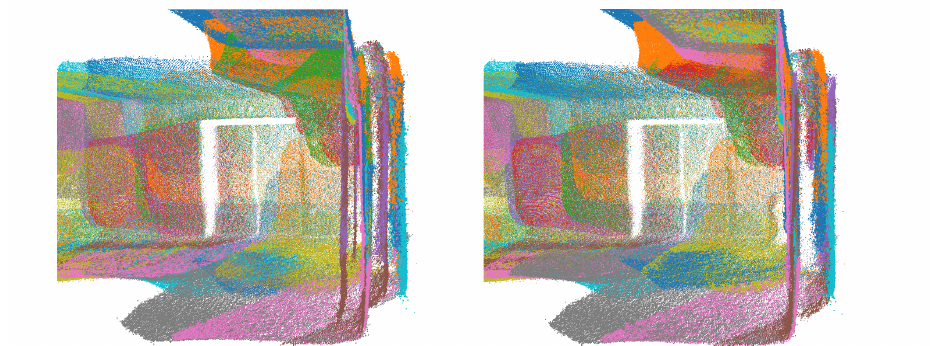
Figure 27. Lobby dataset point clouds coloured using a colourmap: ( left ) Google Tango; ( right ) Our approach.